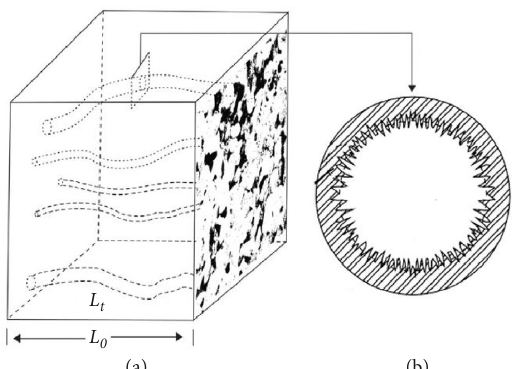
Figure 1: (a) Capillary bundle model for simulating porous media, where L t denotes the actual length of capillaries and L 0 denotes the linear length of the streamline, which is also the side length of the elementary volume. (b) The roughness elements on the pore wall